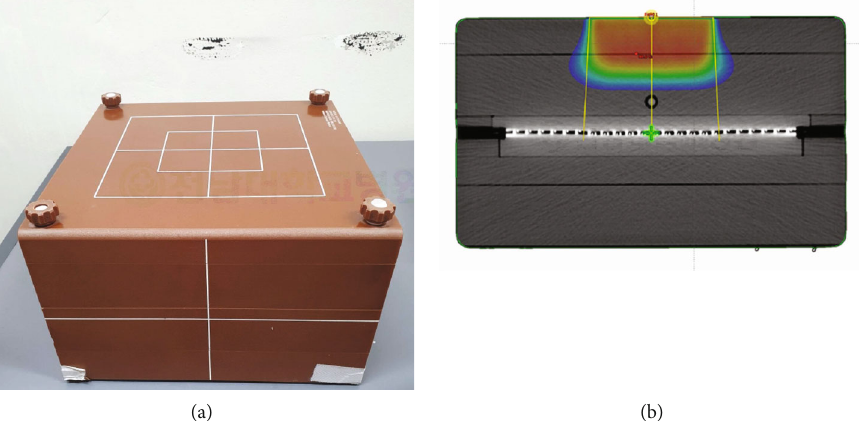
Figure 8: (a) A water equivalent MapPHAN phantom. (b) Image of phantom with 12MeV electron beam. The vertical yellow lines indicate the line of the cone used to prevent electron beams from spreading outward. The black circle represents ion-chamber position for measuring the absolute dose. When the brightest point on the image is set to 100, the distance to the point at which the brightness is 20% is selected to estimate a practical range. The color is arbitrary, and it is shown in rainbow-like